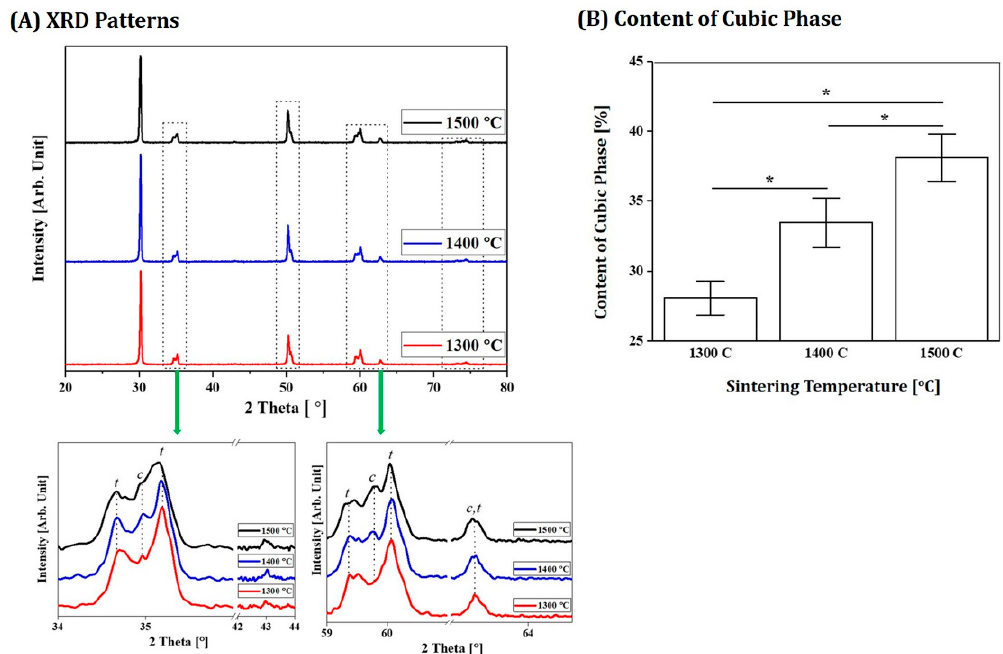
Figure 12. ( A ) Representative XRD patterns of 4Y-PSZ components sintered at various temperatures (1300 °C, 1400 °C, and 1500 °C) and ( B ) contents of cubic phase in components (* p < 0.05). “ t ” and “ c ” indicate tetragonal and cubic phases, respectively.